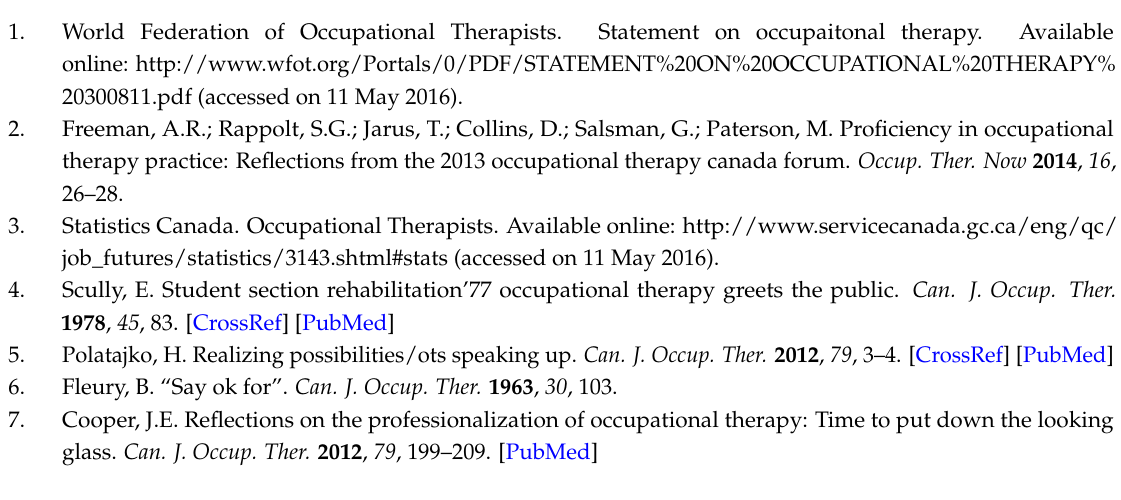
Occupational Concepts Mentioned, Table S2: Medical Terms Mentioned, Table S3: Clients of OT Mentioned, Table S4: Social Concepts and Issues Linked to the Experience of OT Clients and the OT